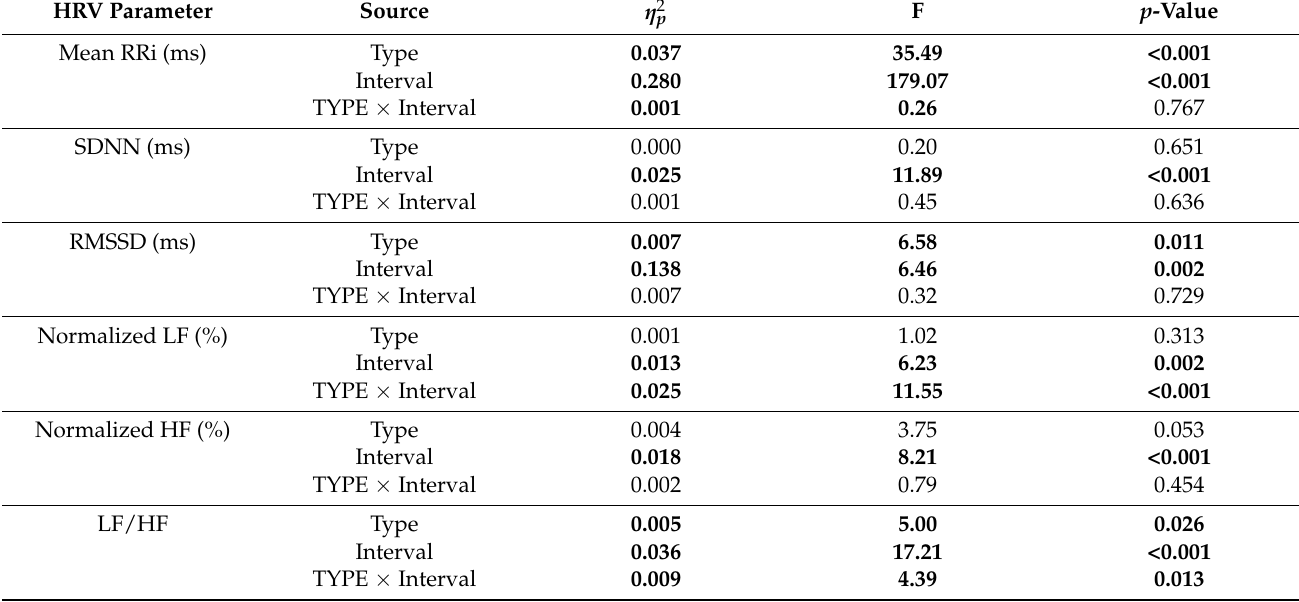
Table 3. Repeated measures ANOVA for HRV